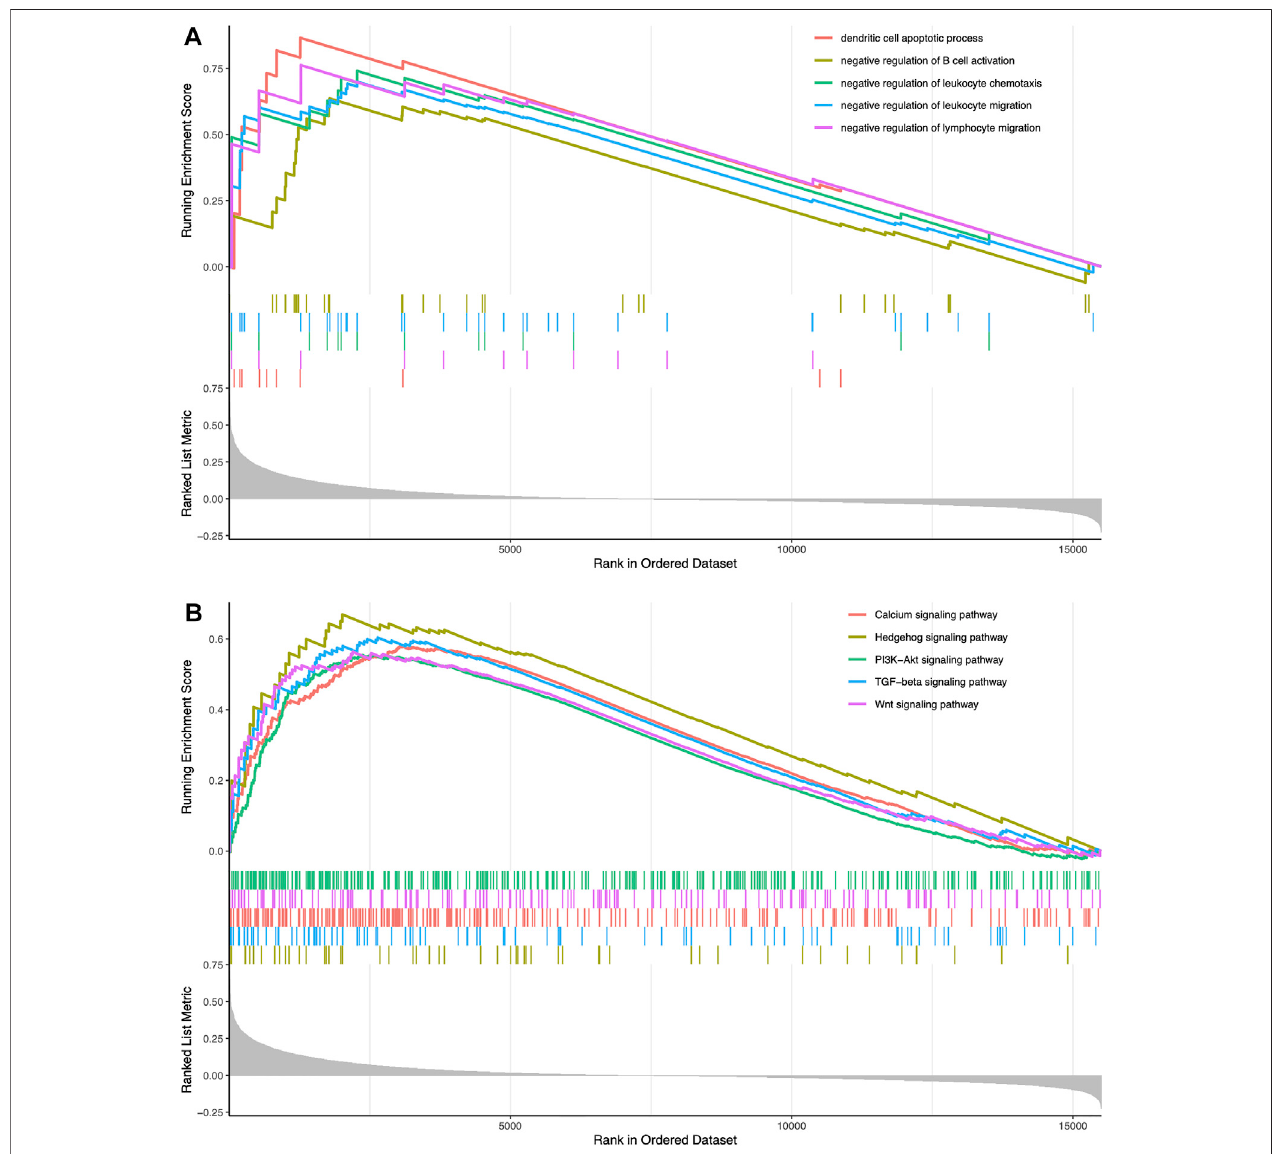
FIGURE 8 | Enrichment-related analysis (A) In the immune gene high-expression group, GO enrichment results showing GO terms were obviously enriched (B) In the immune gene high-expression group, KEGG enrichment results showing its pathways were obviously enriched.